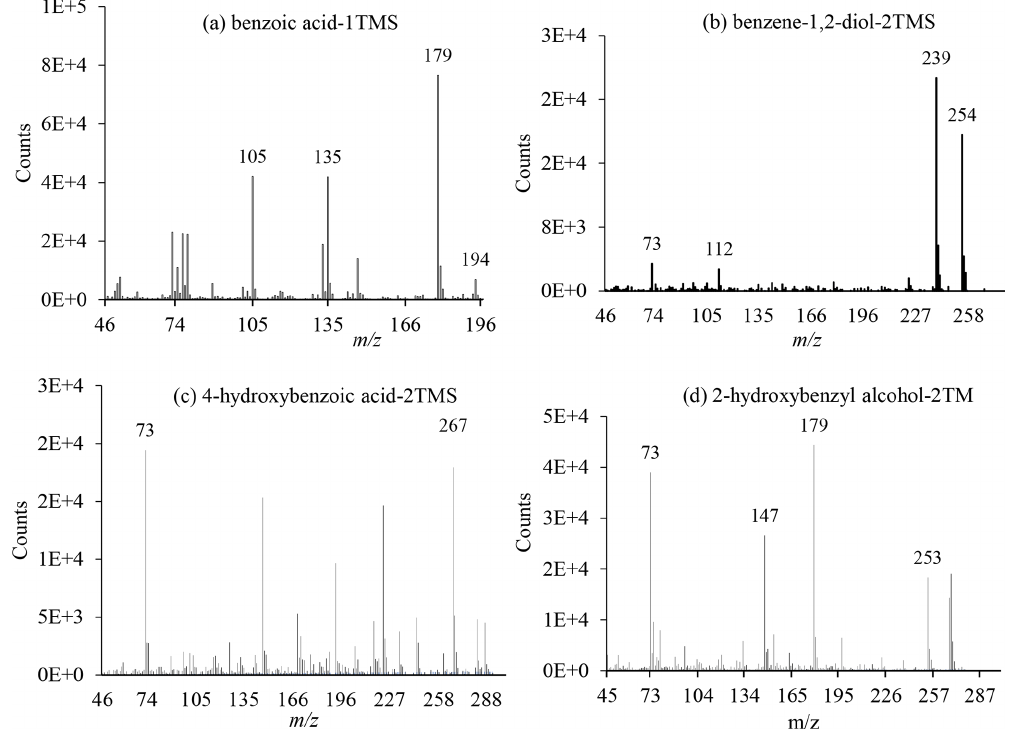
Figure 3. Positive EI mass spectra of BSTFA derivatives of selected ring-containing products: benzoic acid, benzene-1,2-diol, 4- hydroxybenzoic acid, and 2-hydroxybenzyl